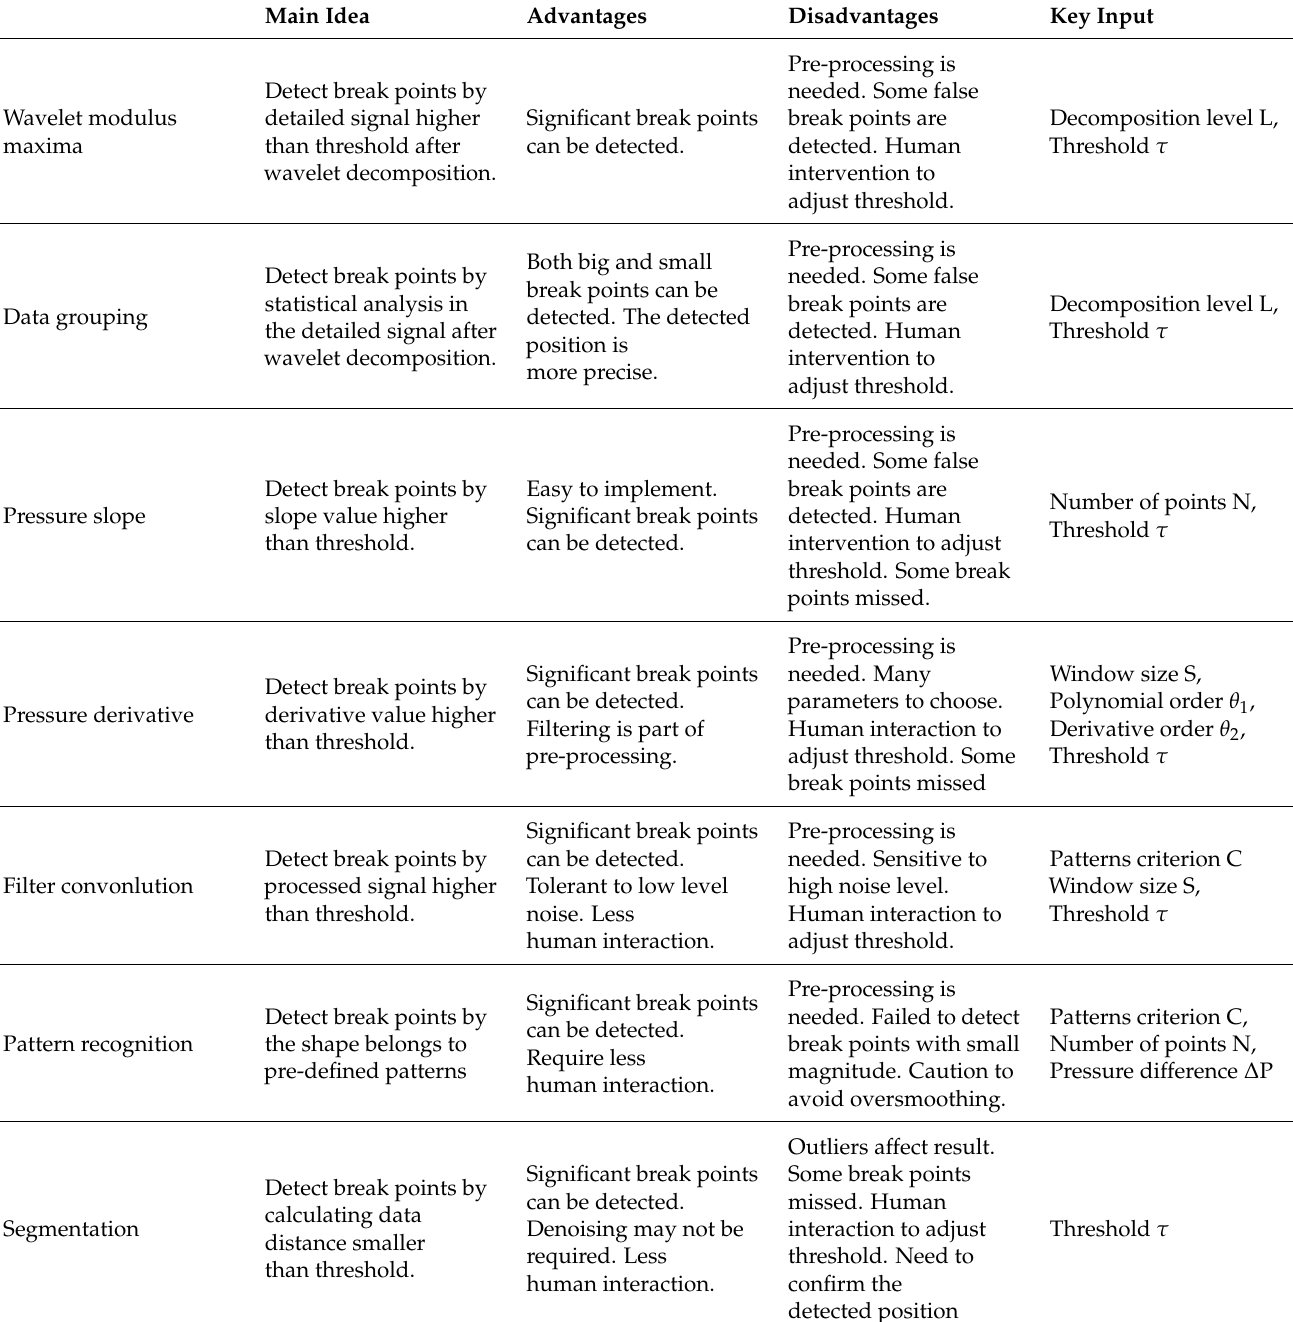
Table 1. Comparison among different methods for